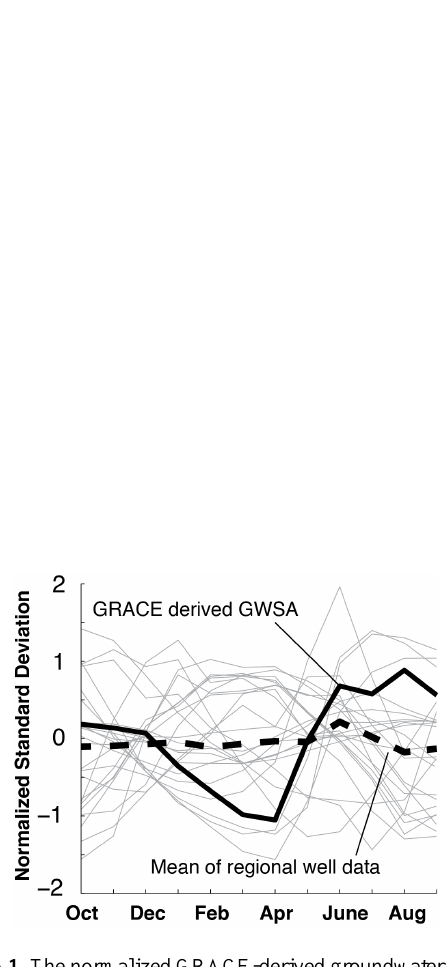
Figure A1. The normalized GRACE-derived groundwater anomaly compared to normalized well data over the study period. The grey lines in the background are the 33 individual wells, and the hashed line represents the mean of these wells. While some wells match the general GRACE-derived GWSA, variability across wells creates a muted mean